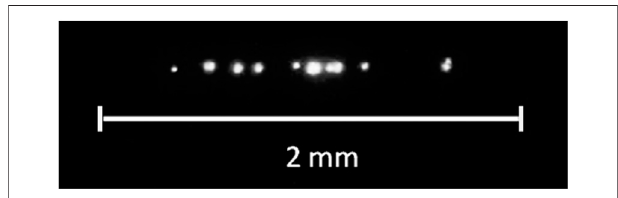
FIGURE 1 | Pattern of optical breakdown in water irradiated with a laser pulse at a wavelength of λ (cid:2) 1,064 nm, the pulse duration is 15 ns.